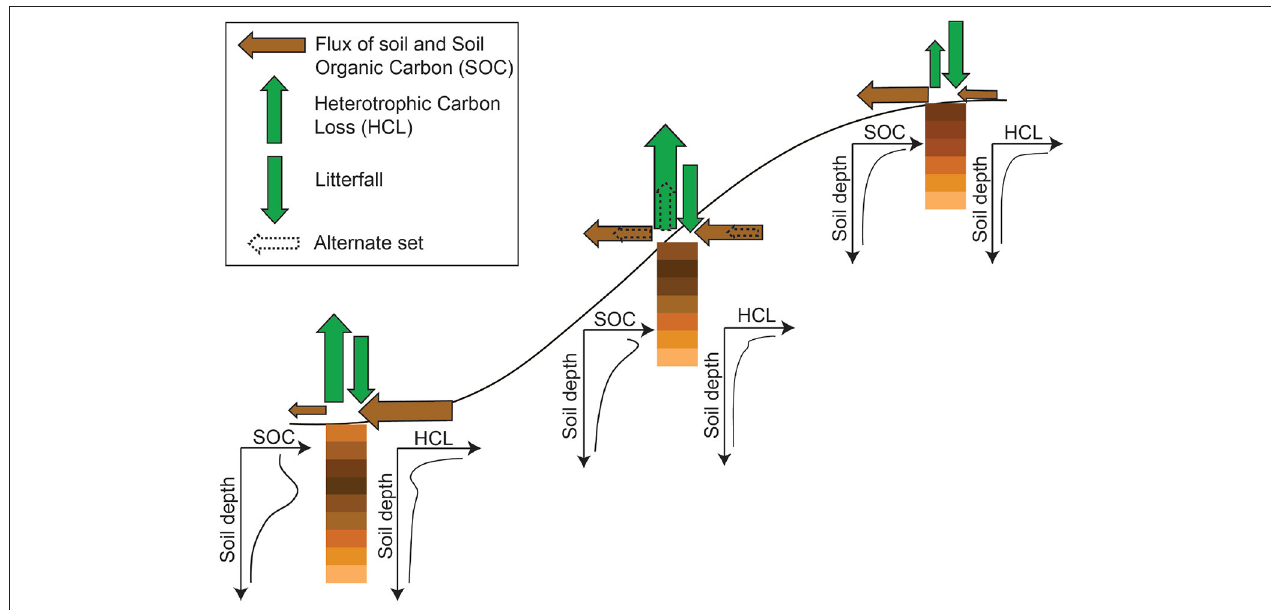
FIGURE 9 | Schematic of conceptualized SOC and HCL profiles at a hillslope under high soil erosion and deposition processes. “Alternative set” here means that the arrows that represent the carbon fluxes both laterally and vertically have two scenarios at sites where the lateral influx and efflux of soil material are similar (which results in a small soil thickness change rate). Specifically, if the lateral influx and efflux of soil material are both small, the corresponding HCL is also small; if the lateral influx and efflux of the soil material are both quite large, the corresponding HCL tends to be high as